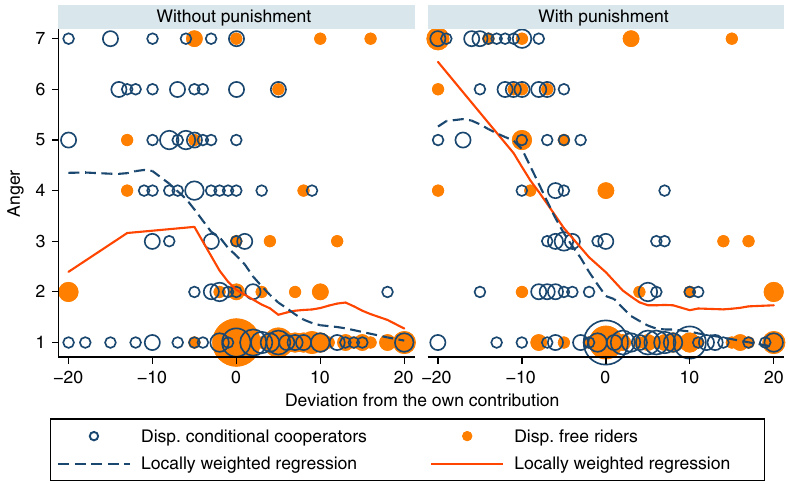
Fig. 2 Self-reported anger levels depend on the deviation from the own contribution. Participants indicated the intensity of anger on a scale from 1 (not at all) to 7 (very much). The size of the bubbles corresponds to the number of observations at this location. The lines indicate the locally weighted regression functions of DCC (dark blue) and DFR (orange), and are very similar for both types. In both treatments, DCC and DFR feel angrier as group member ’ s negative deviations from the own contribution are (Mann – Whitney z belief = − 2.00, P belief = 0.046; z contribution = −